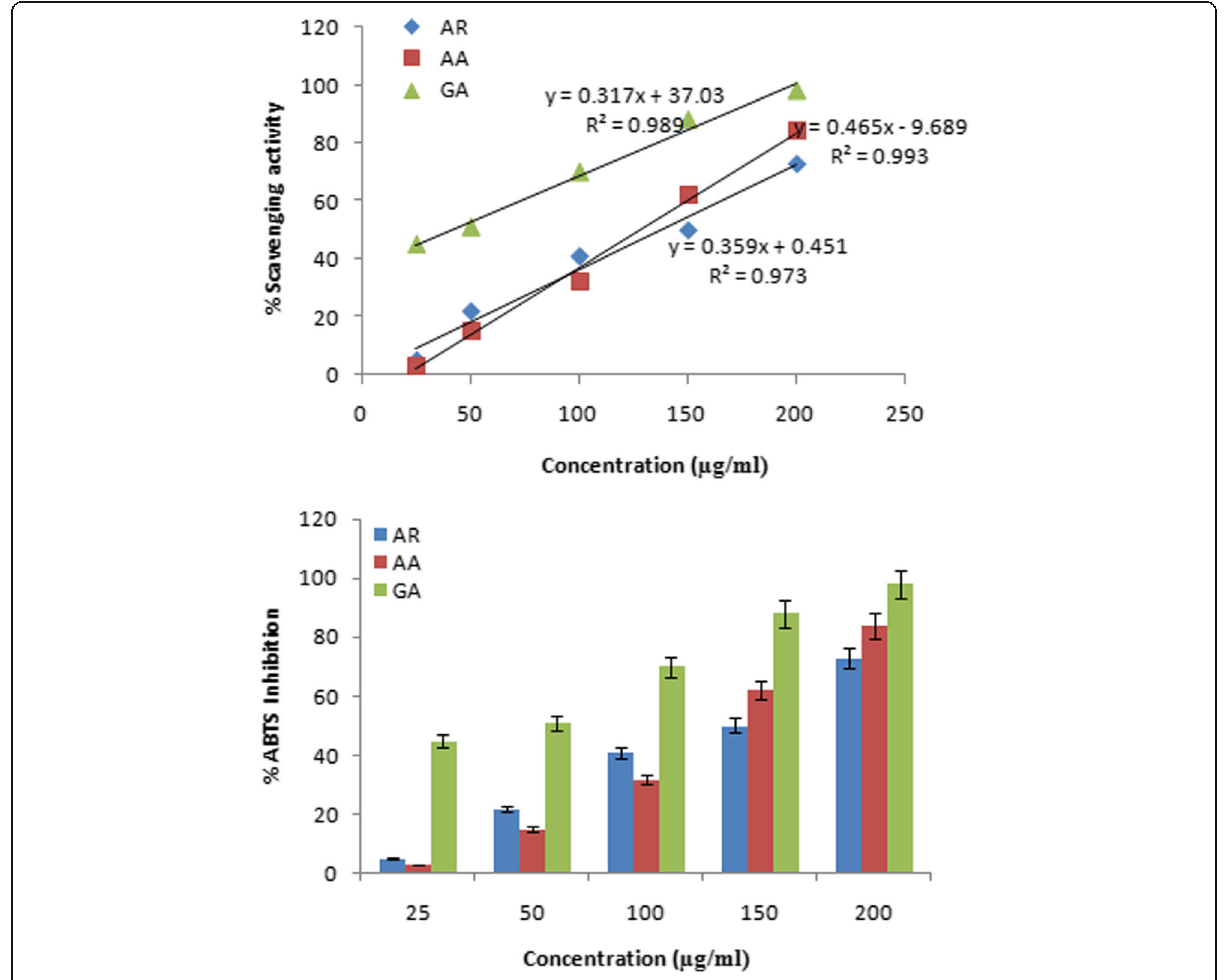
Fig. 3 Scavenging of ABTS free radical by AR rhizome extract a ) The linear regression curve and b ) Percent of ABTS inhibition. Data represents the mean of three replicates. Ascorbic acid and Gallic acid were used as standard. **AR- Astilbe rivularis, AA- Ascorbic acid, GA- Gallic